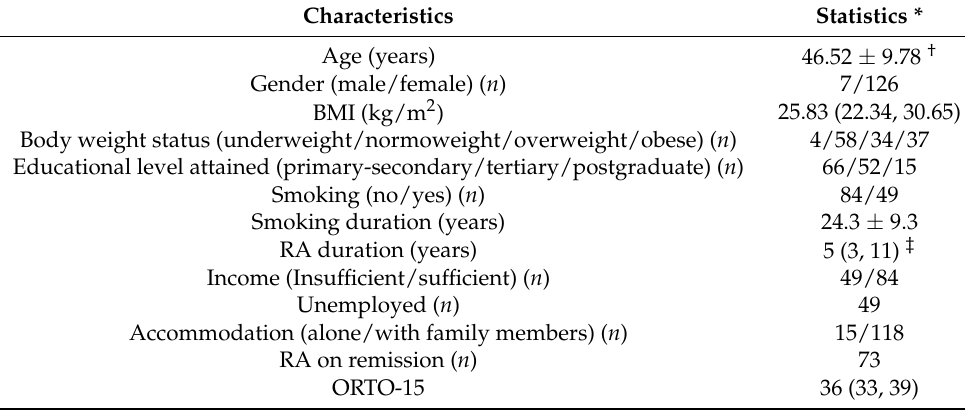
Table 1 details the descriptive characteristics of the participants. Table 1. General characteristics of the participants (N =